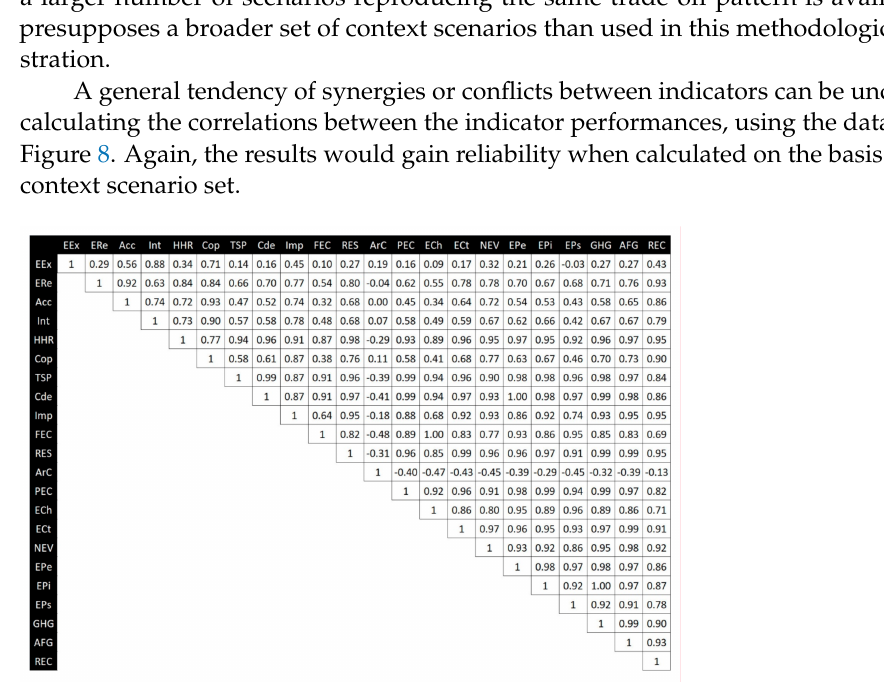
Figure 8. Indicator correlations (for emphasizing the relevance of the zero line, no mean value correction was applied in the calculation of the correlation